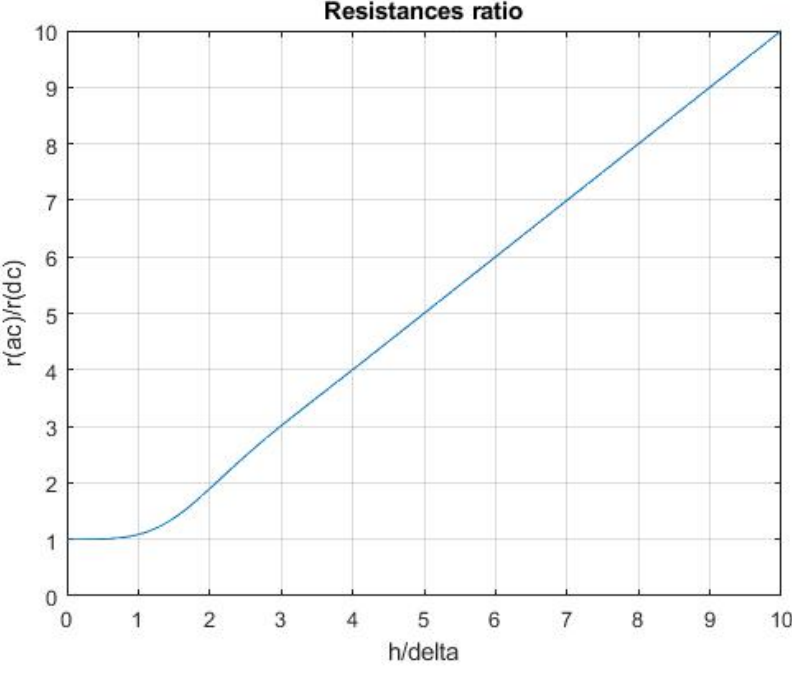
Figure 4. Ratio between r AC and r DC